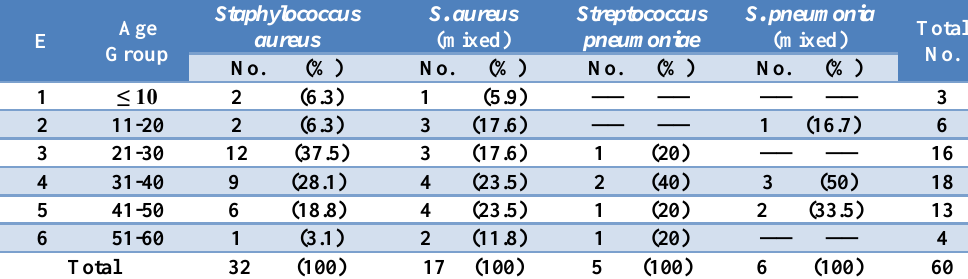
Table, 2: Distribution of isolates in relation to patients' ages Age E Group